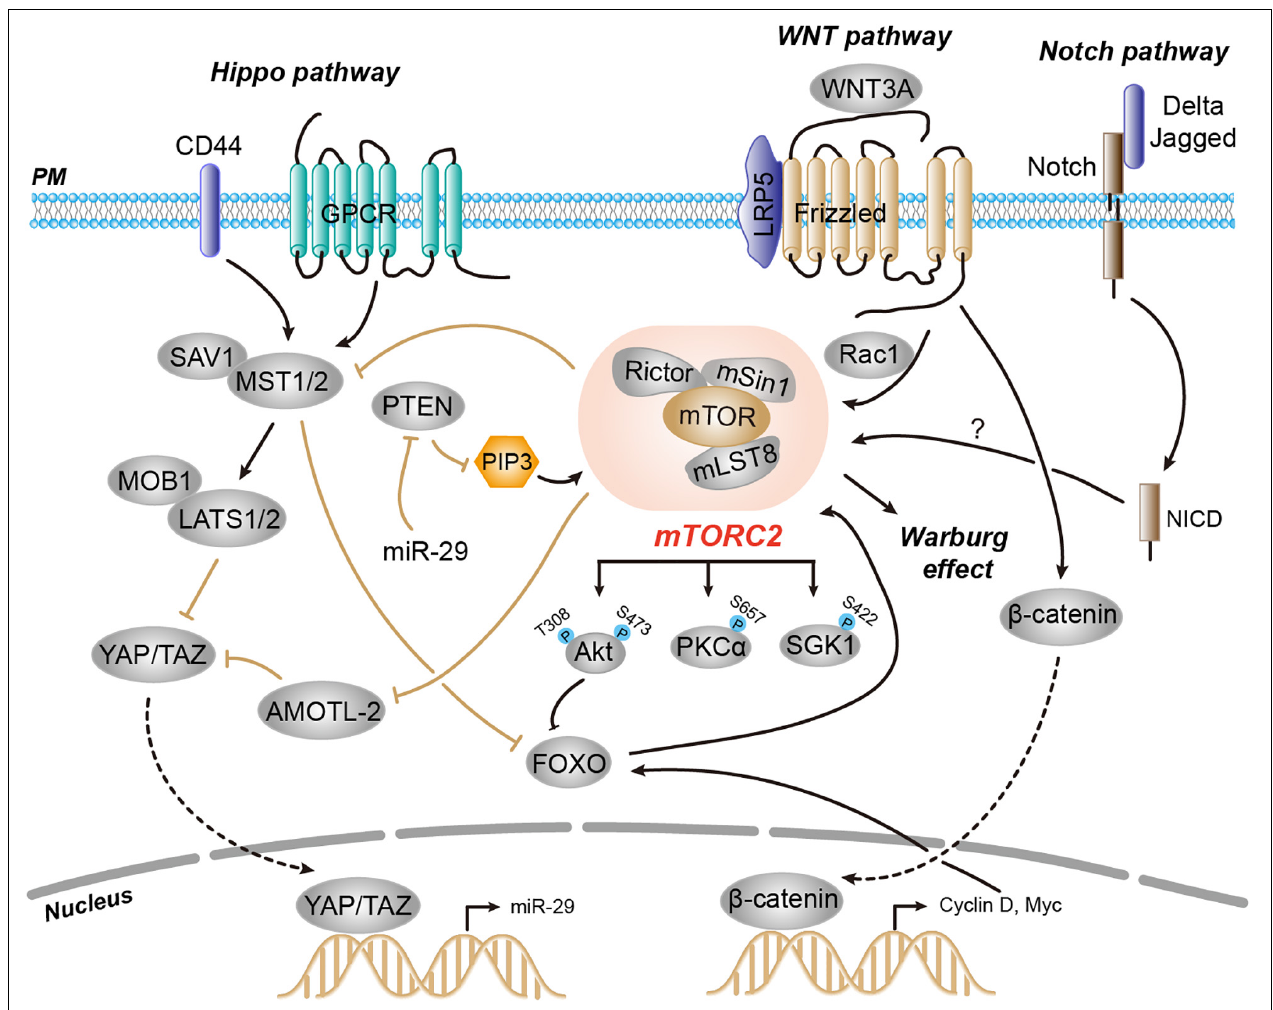
FIGURE 3 | Regulation of mTORC2 activity through crosstalk with other signaling pathways, including Hippo, WNT, and Notch, which act both upstream and downstream of mTORC2. During Hippo inactivation, active and hypophosphorylated YAP translocates to the nucleus and promotes expression of miR-29. The miR-29 targets PTEN mRNA and inhibits its translation, which leads to increased levels of PIP 3 and activation of both mTORC1 and mTORC2. Another key component of the Hippo pathway, Mst1, phosphorylates and inactivates FOXO1 and substrates of mTORC2-Akt, and thereby regulates mTORC2 downstream signaling. mTORC2 is activated by WNT in a manner dependent on the small GTPase RAC1. Notch signaling promotes mTORC2 activation possibly through PINK1 and mitochondria.